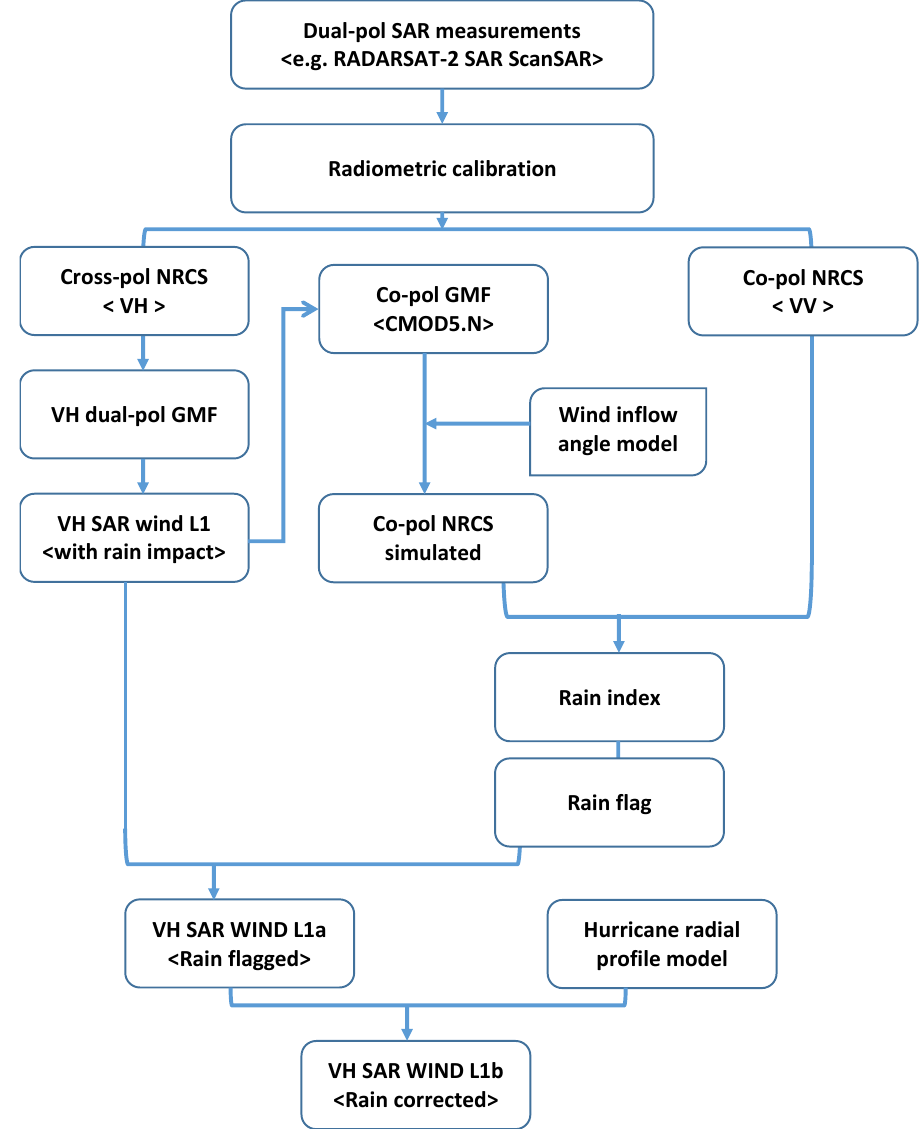
Figure 3. Flowchart of the hurricane wind quality index from SAR with proposed rain correction procedure.